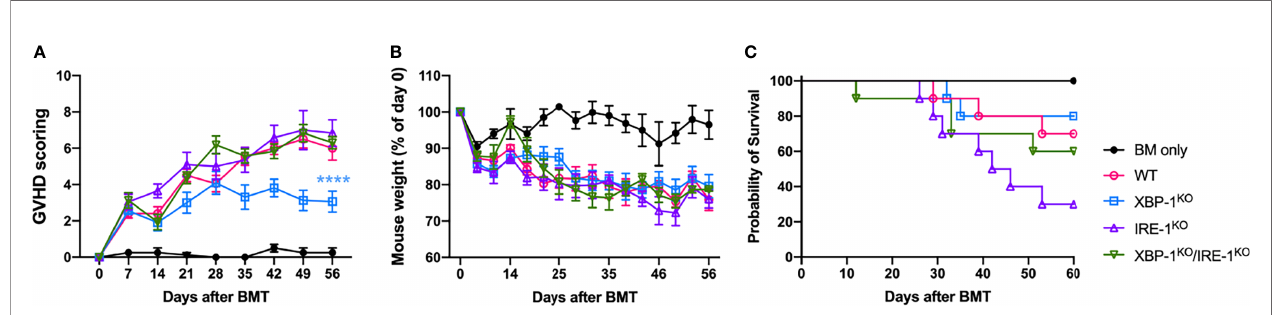
FIGURE 3 | Long-term impact of XBP-1s and IRE-1 a on B cell pathogenicity in the induction of cGVHD. BALB/c mice were lethally irradiated and transplanted with 5 x 10 6 T cell-depleted bone marrow (TCD-BM) cells from WT (n = 4) or TCD-BM from WT, XBP-1 KO , IRE-1 a KO , and DKO mice on a B6 background with 0.35 - 0.5 x 10 6 splenocytes (n = 40). Recipient mice were monitored for the GVHD scoring (A) , weight loss (B) , and mortality (C) until 60 days after BMT. Data show results from two out of three independently repeated experiments. 22 recipient mice were used for each experiment. Statistics for scoring and weight were performed using two-way ANOVA with Tukey ’ s multiple comparison test. Comparisons of the survival distributions of any given groups were done using log-rank test. ****p < 0.0001 when compared